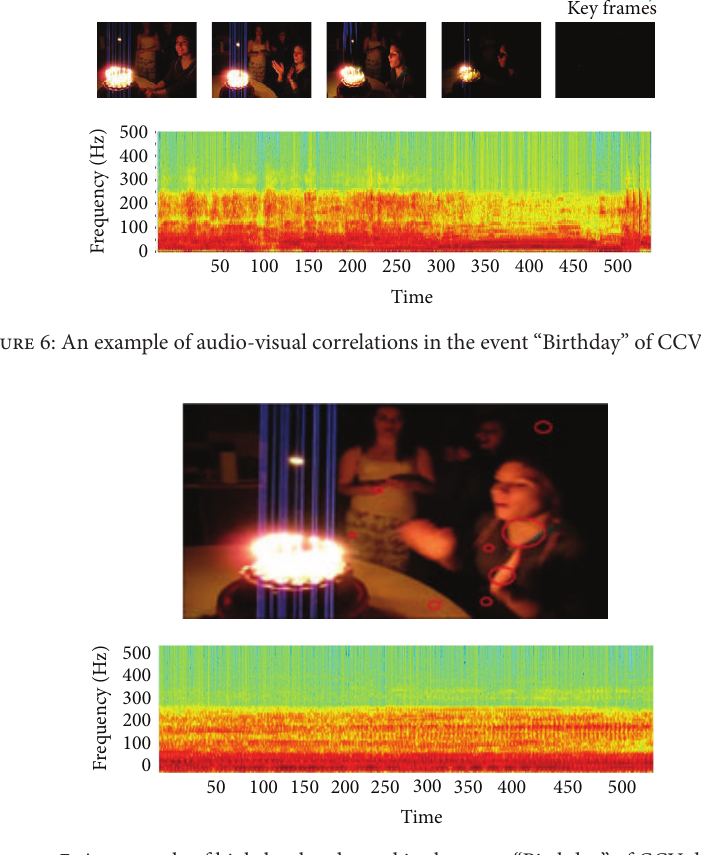
Figure 7: An example of high-level codeword in the event “Birthday” of CCV dataset.